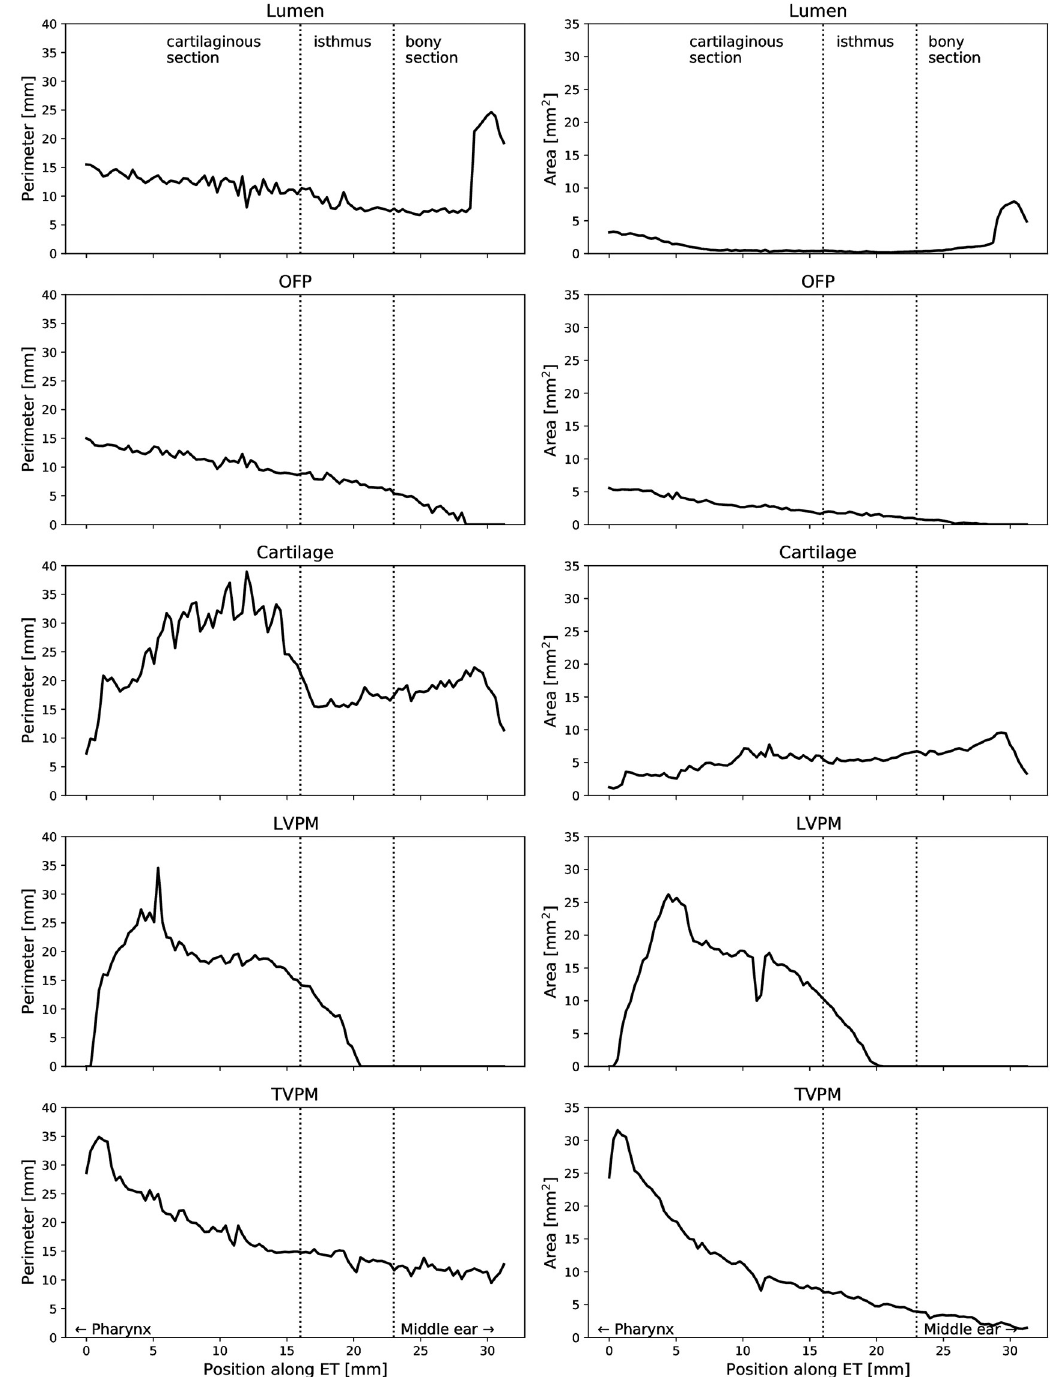
Fig 5. The plots show the quantitative analysis as a function of the position in the ET axis with respect to area and circumference for the individual entities cartilage, lumen, OFP, TVPM and LVPM (a).